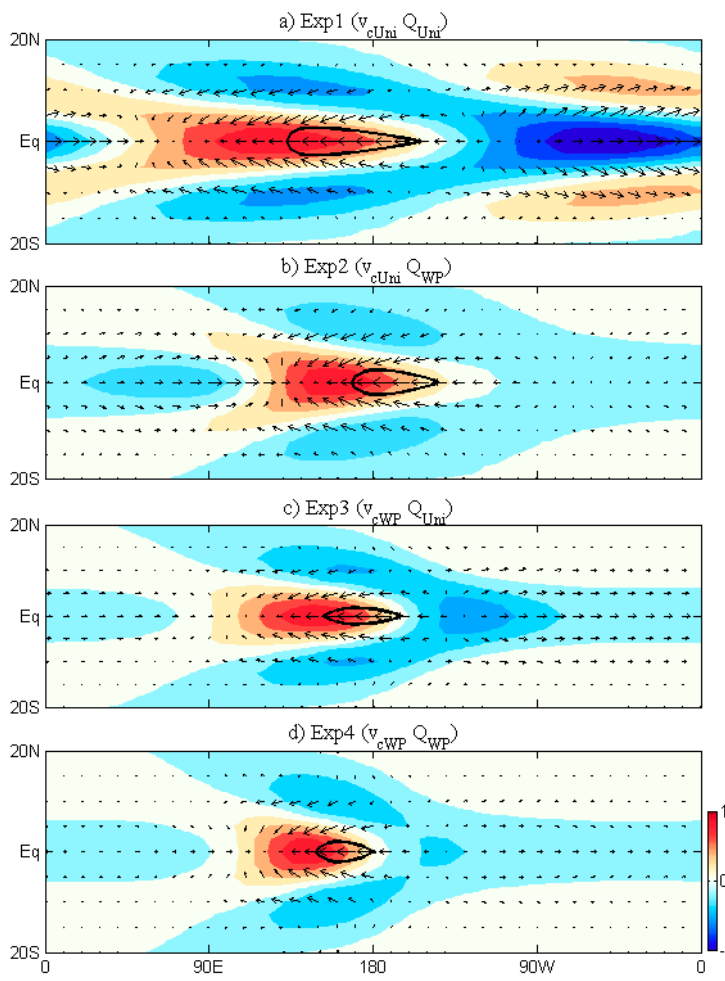
Figure 8. Horizontal structures in different experiments. Shown are normalized precipitation (shading) and lower-level wind (vector) at day 30 in: ( a ) Exp 1; ( b ) Exp 2; ( c ) Exp 3; and ( d ) Exp 4. The 0.8 amplitude of the upward PBL Ekman pumping (thick black contour) is also shown.